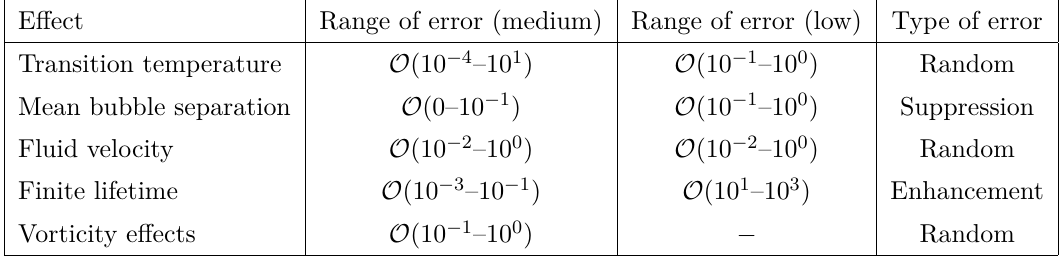
Table 1 . Full range of error of ∆Ω / Ω for each individual effect comparing the medium diligence and low diligence approaches to the high diligence